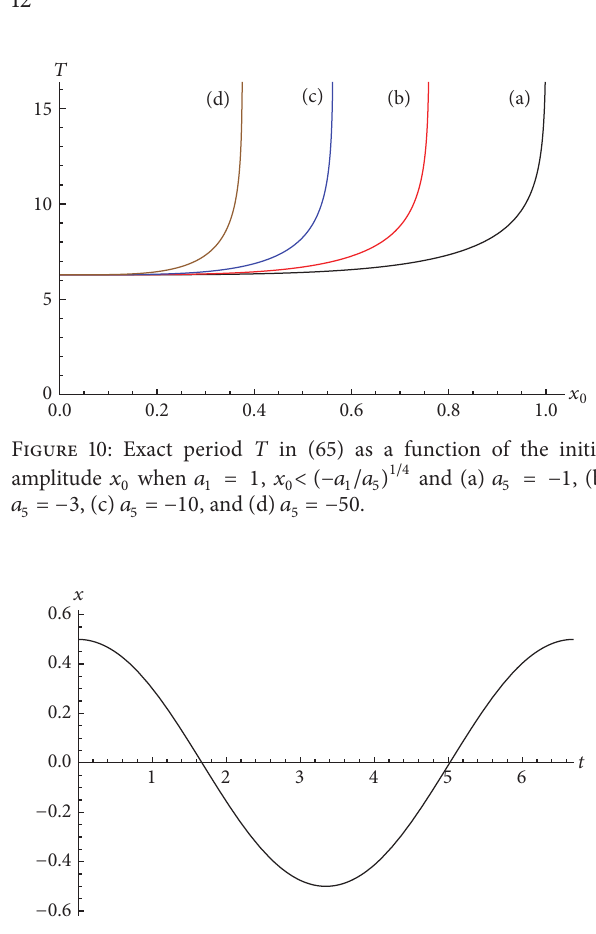
Figure 11: Exact solution 𝑥 in (69) as a function of time t when 𝑎 1 = = −3 , and 𝑥 = 0.5 1 , 𝑎 5 0